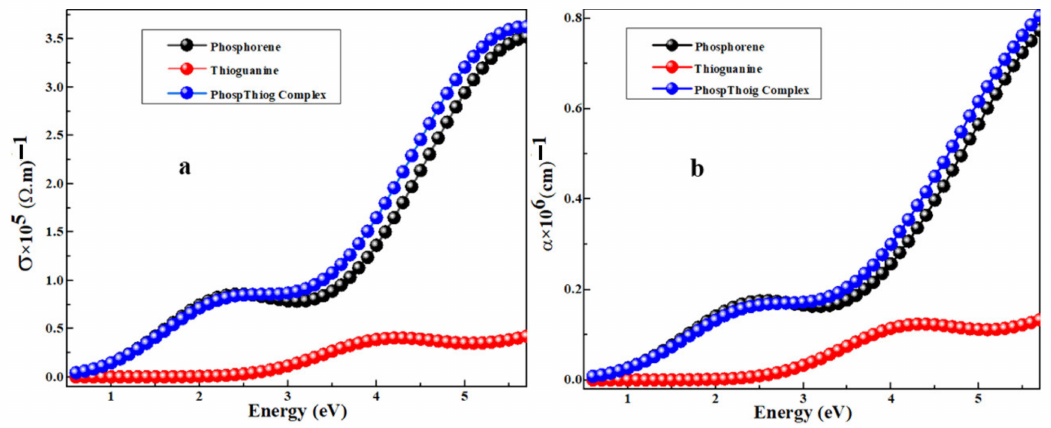
Figure 8. Analysis of ( a ) optical conductivity and ( b ) optical absorption spectra of phosphorene, thioguanine, and their complex